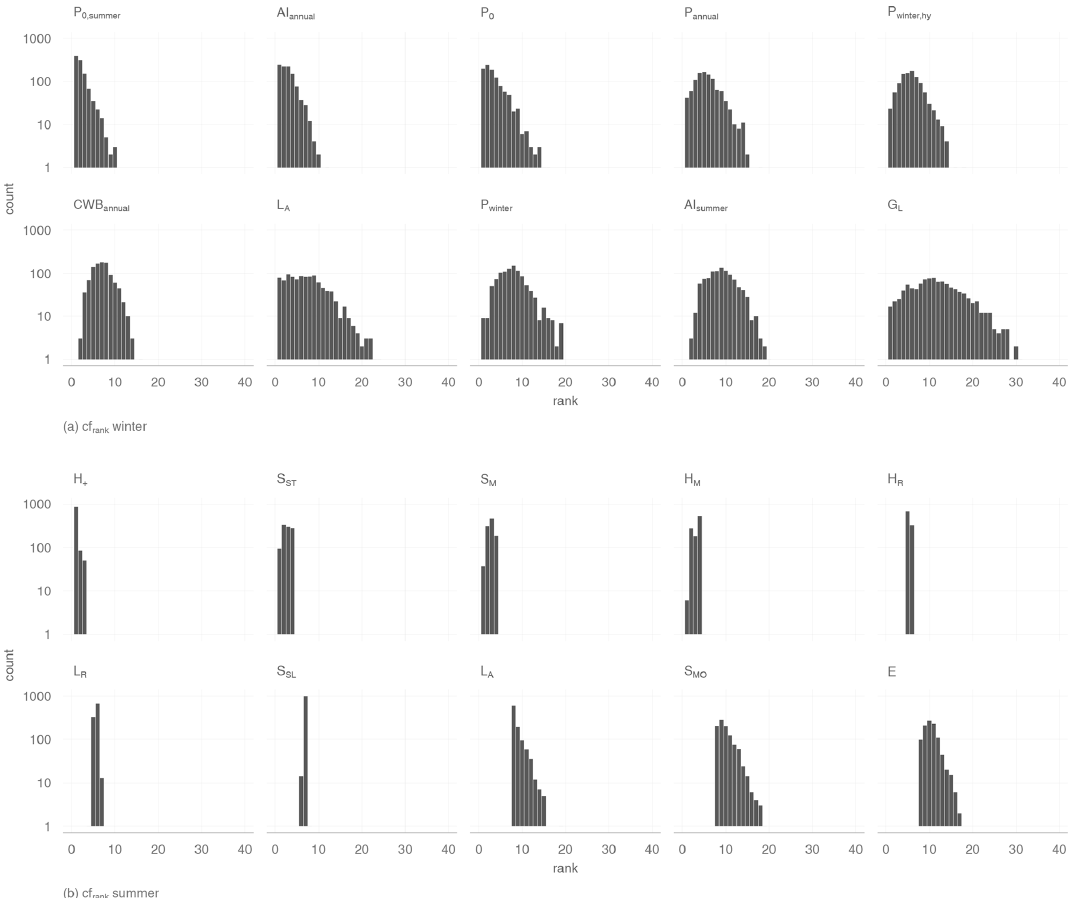
Figure A3. Count of all variable rankings of all 1000 iterations on a log scale for summer low flow. The 10 best variables are listed after their averaged